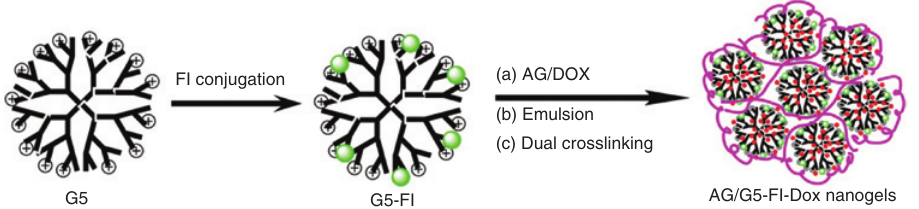
Figure 1: Preparation procedure of nanogels made from DOX-loaded fluorescent dendrimers and AG. Reproduced from Ref. (34). Copyright ©2014, American Chemical